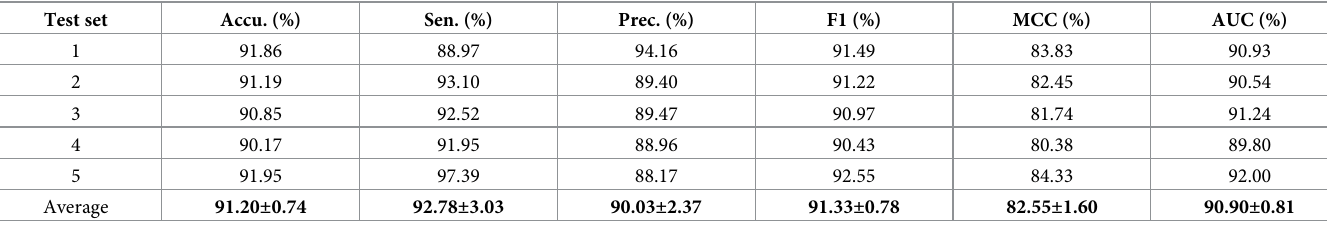
Table 1. Results of 5-fold CV generated by GCNCDA on circR2Disease dataset. Test set Accu.